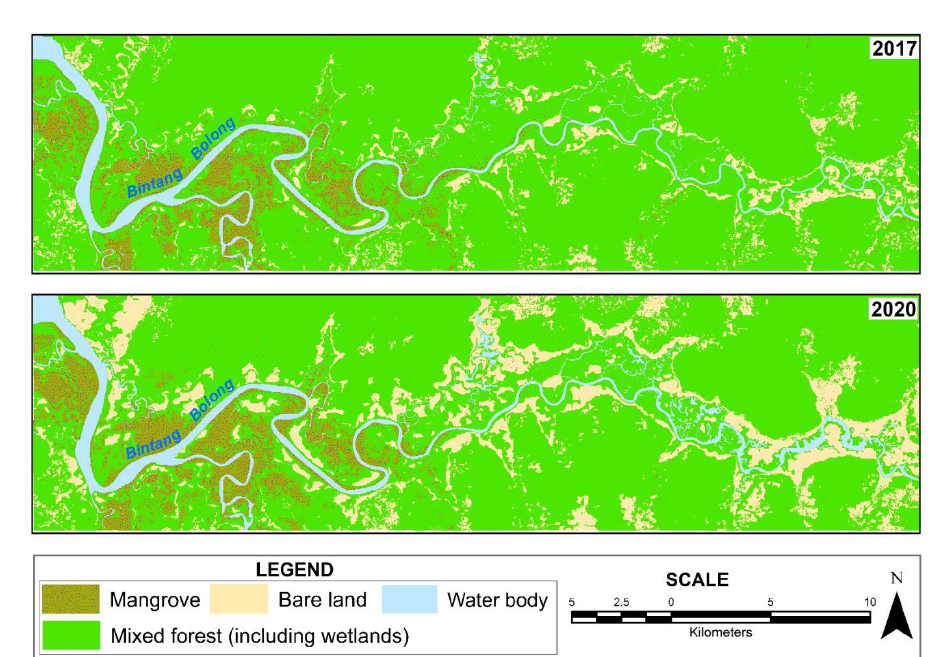
Figure 3 . Random forest classification – 2017 (top) and 2020 (bottom)